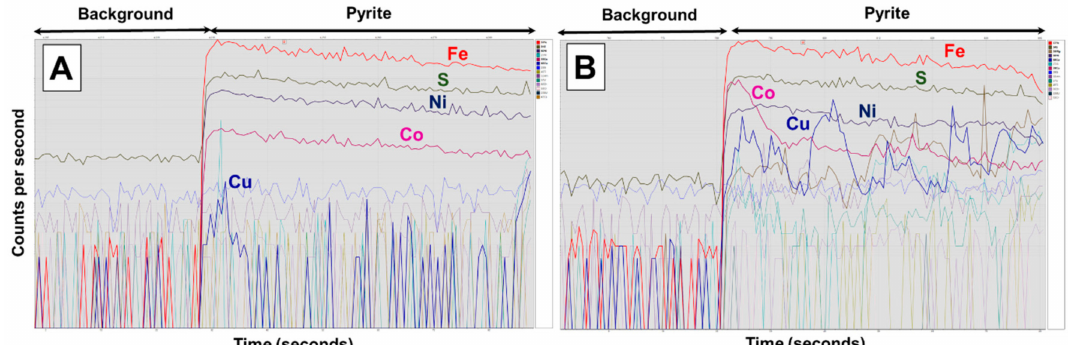
Figure 8. Examples of laser ablation ICPMS (LA-ICPMS) traces for pyrite contained in the rougher concentrate. ( A ) Co and Ni appear as refractory within pyrite as their trace is roughly similar to that for Fe and S; ( B ) Cu inclusions are seen within pyrite (i.e., appearance of large spikes) with Co showing zoning in the pyrite